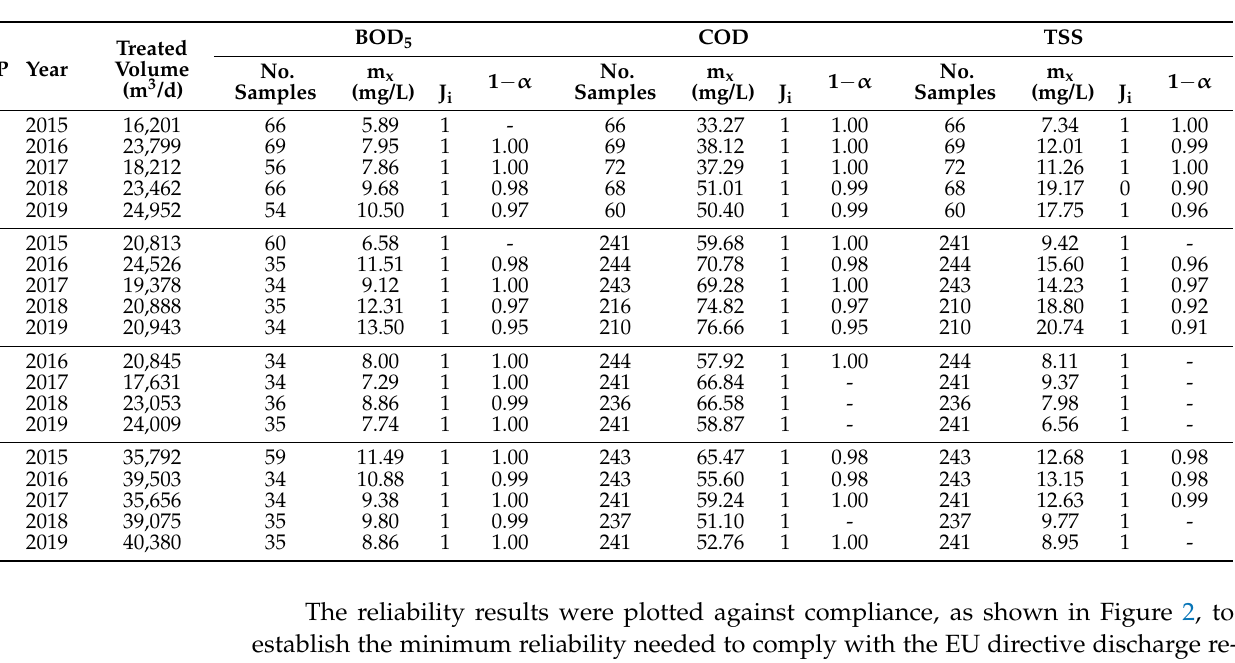
The reliability results were plotted against compliance, as shown in Figure 2, to establish the minimum reliability needed to comply with the EU directive discharge re- quirements, i.e., for ensuring X s (Equation (1)) of 25 mg/L BOD 5 , 125 mg/L COD, and 35 mg/L TSS.